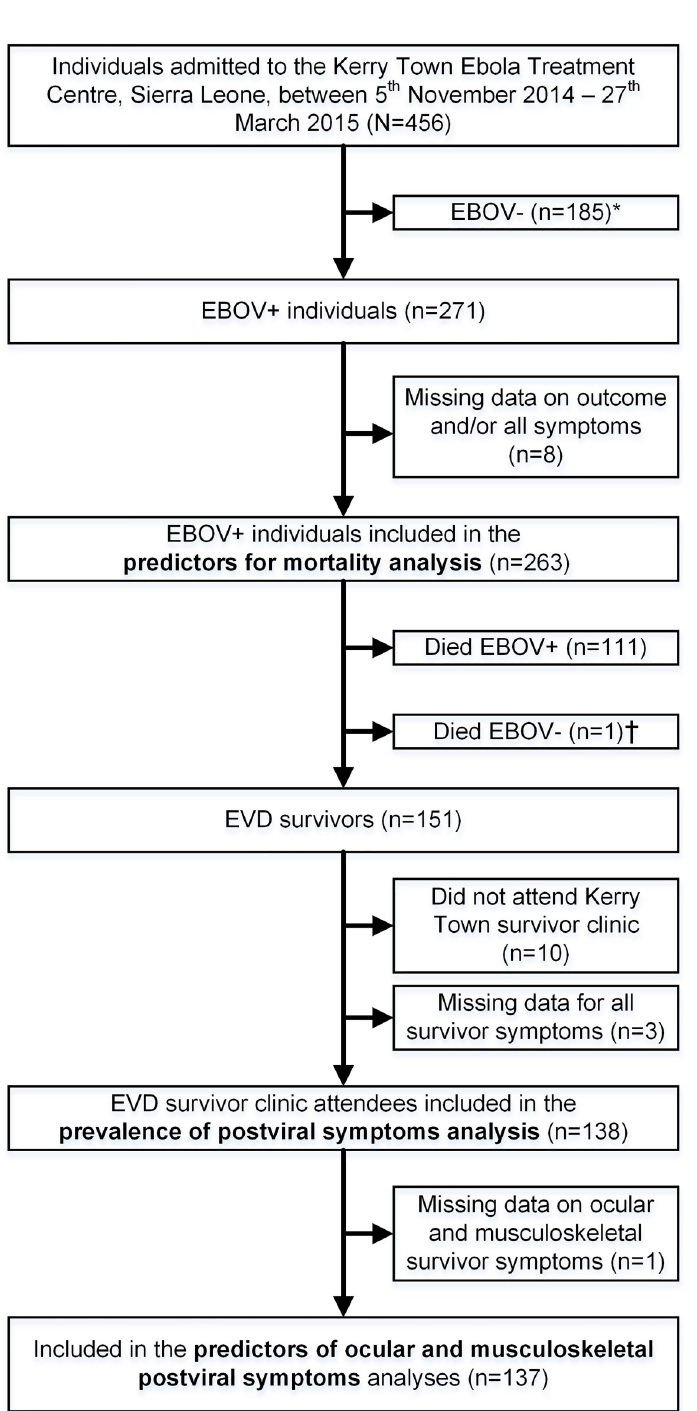
Fig 1. Flow diagram of individuals included in the analysis of EVD mortality and survival in Kerry Town, Sierra Leone, 2014–2015. � EBOV-: Admitted to the ETC as a suspect case based upon meeting EVD case definition. Laboratory test for EBOV performed at laboratory located at Kerry Town ETC and result was negative. Individual discharged (or referred) and not included in this study. †Died EBOV-: Person recovered from Ebola (i.e. three EVD symptom-free days and two consecutive EBOV-negative tests) but then died during the ETC discharge procedure. Classified as “recovered” in the mortality analysis, but not included as a survivor in the survivor analysis as did not survive to discharge from the